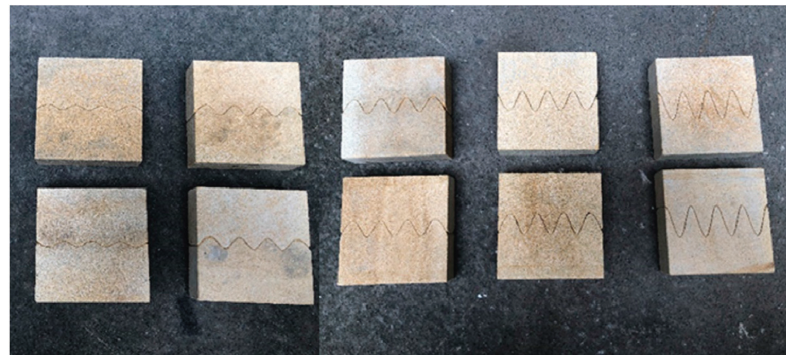
Figure 1: Specimens of fractures with different undulated heights.